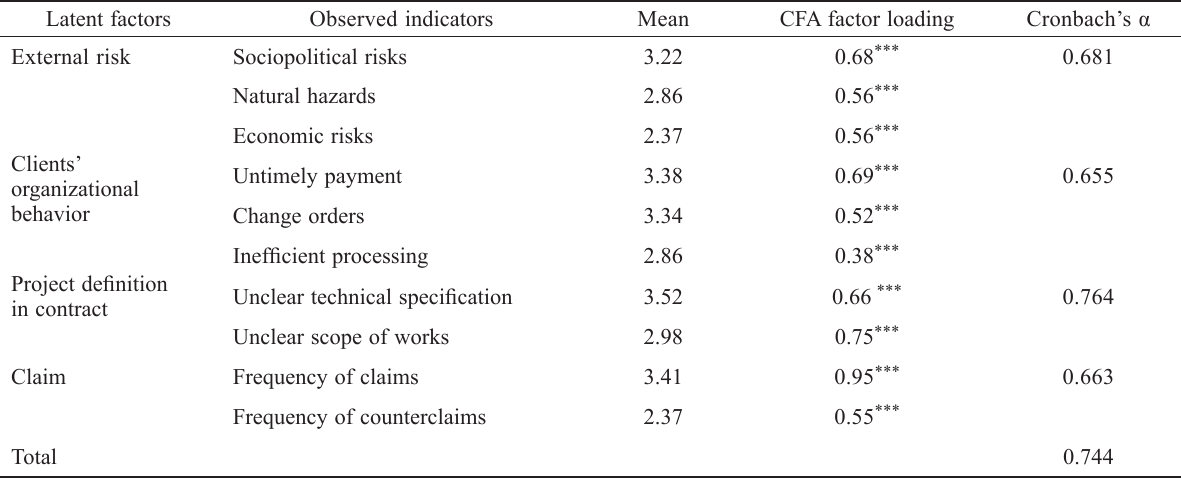
Table 2. Survey results on causes of contractors’ claims in international EPC projects